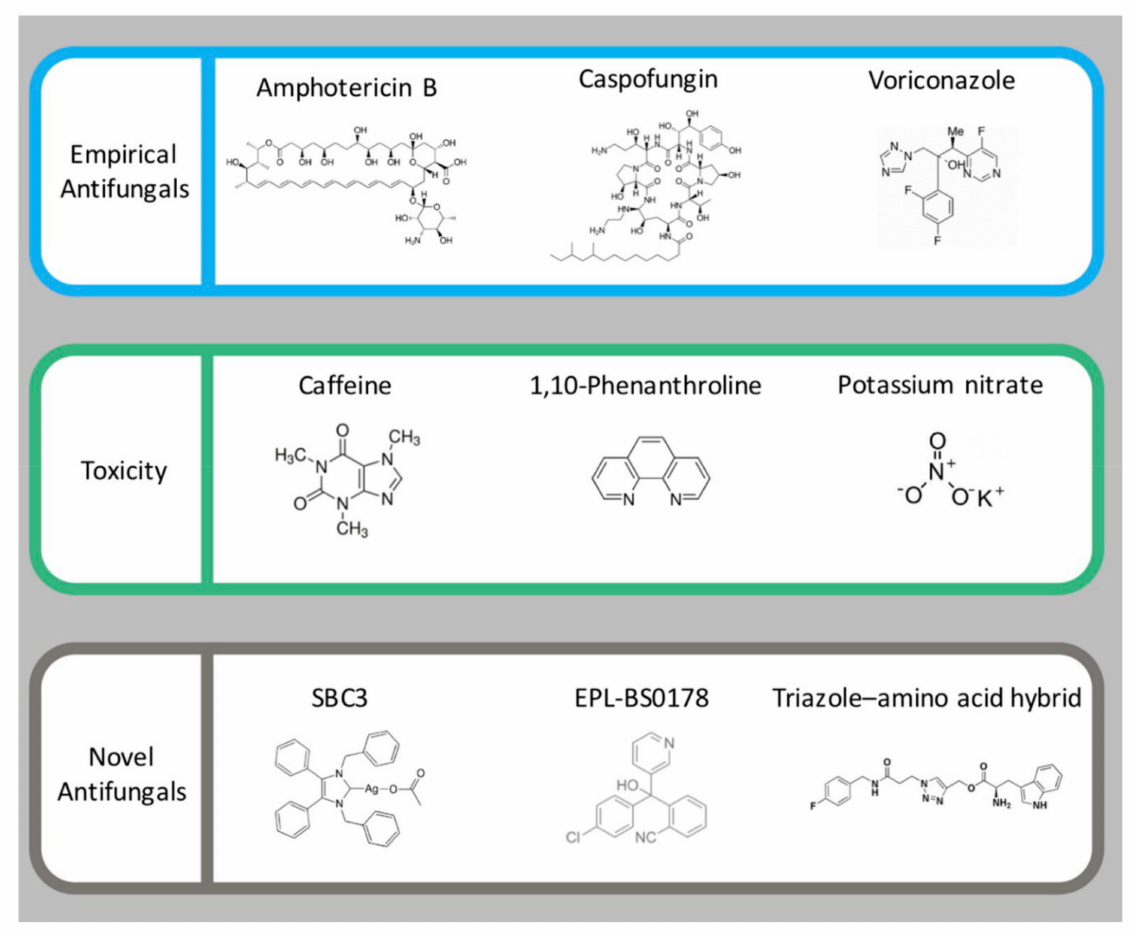
Figure 3. Examples of uses of G. mellonella larvae to assess the in vivo toxicity and efficacy of a range of antifungals and chemical agents. Structures of empirical antifungals amphotericin B [43], caspofungin [44], voriconazole [31]. Chemicals used for toxicity studies; caffeine [9], 1,10-Phenanthroline [41]